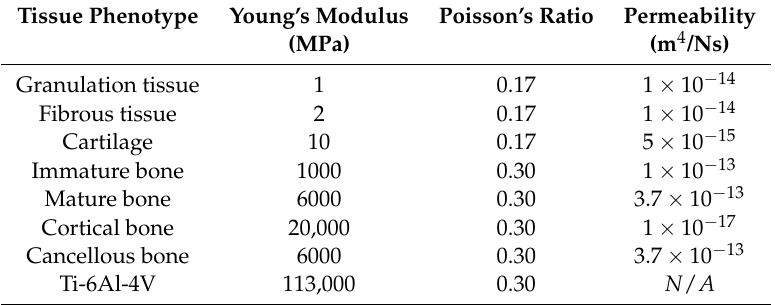
Figure 6. The schematic plots of ( a ) the model with boundary conditions and ( b ) ROI of BIC and BA in one of the threads. Table 2. The material properties used in the current work